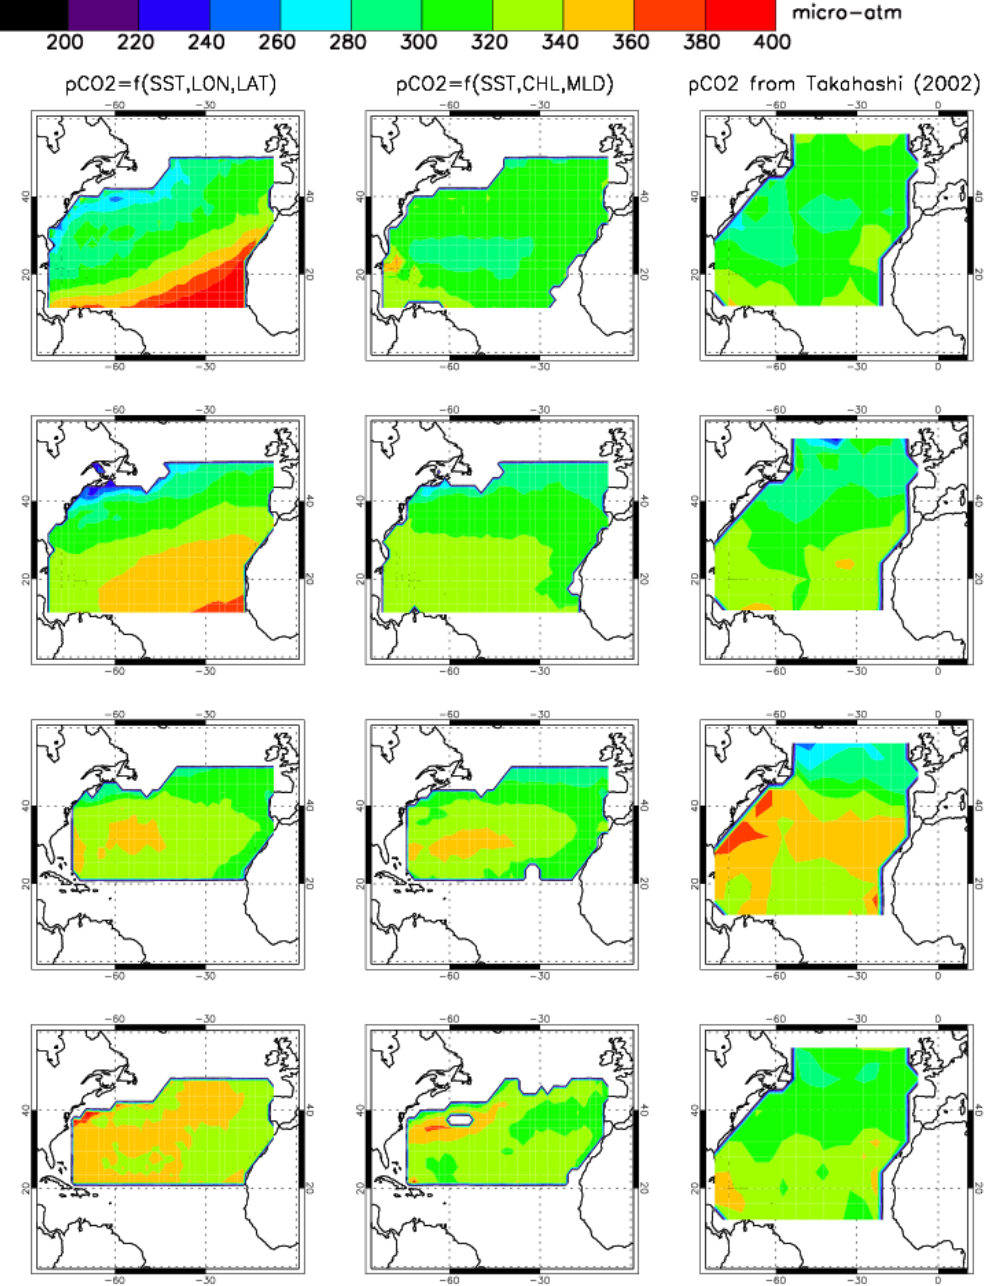
Fig. 5. Seasonal pCO 2 maps. From left to right: pCO 2 = f (longitude, latitude, SST), pCO 2 = f (SST, CHL, MLD), pCO 2 from the climatology of Takahashi et al. (2002). Top to bottom: Winter, Spring, Summer,